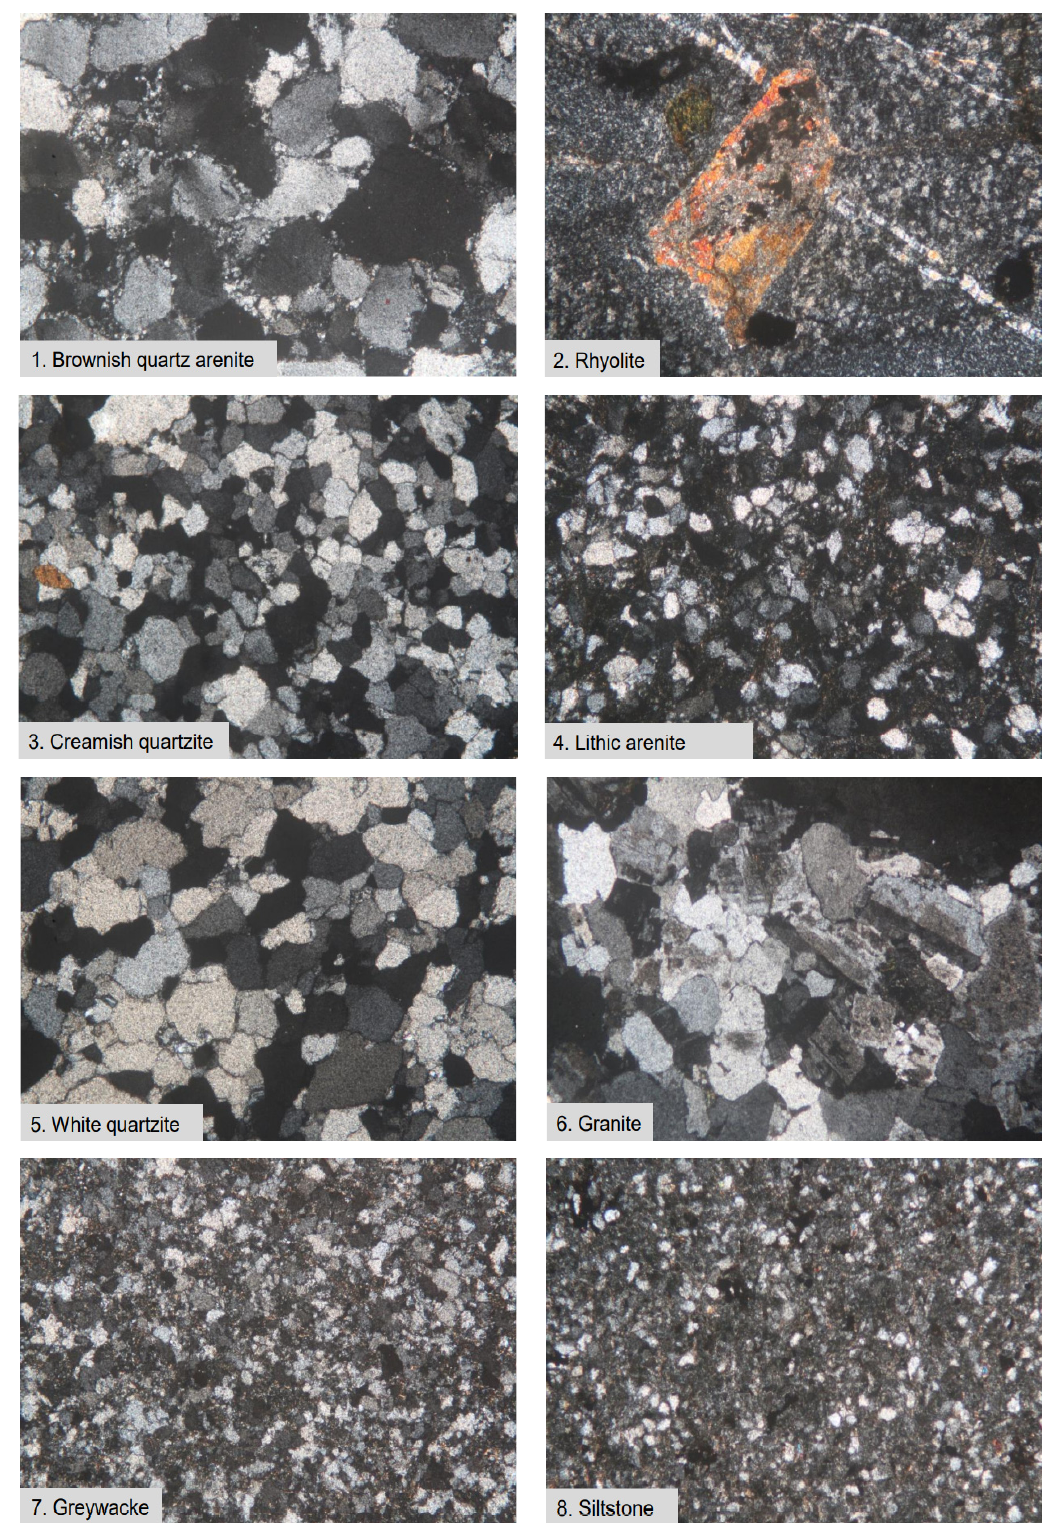
Figure 5. Photomicrographs of Jhelum aggregates . The granite rock was medium grained, hypidiomorphic and subporphyritic. Quartz (31.5%) was mainly from subhedral to anhedral. About 25% of quartz grains showed strong strain extinction. K-feldspar (35%) occurred as subhedral and showed an alteration to sericite. Albite/oligoclase (16.5%) occurred as prismatic grains and showed an alteration